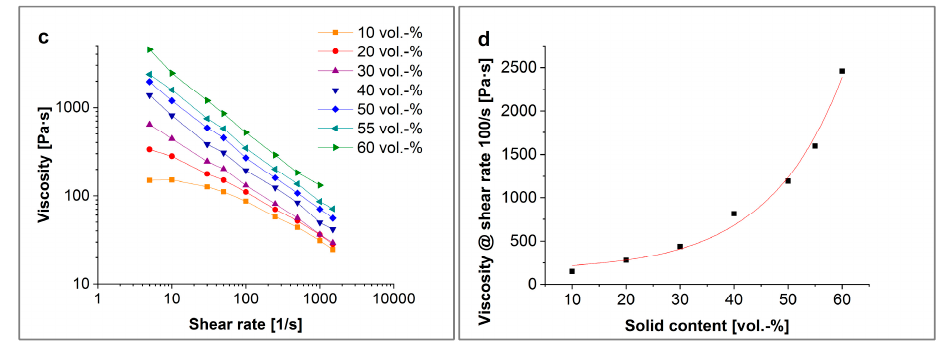
Figure 5. ( a ) Kneading diagram at 125 °C, ( b ) ending torque at 125 °C, and ( c ) viscosity at 160 °C, and ( d ) viscosity at 100 s − 1 at 160 °C.